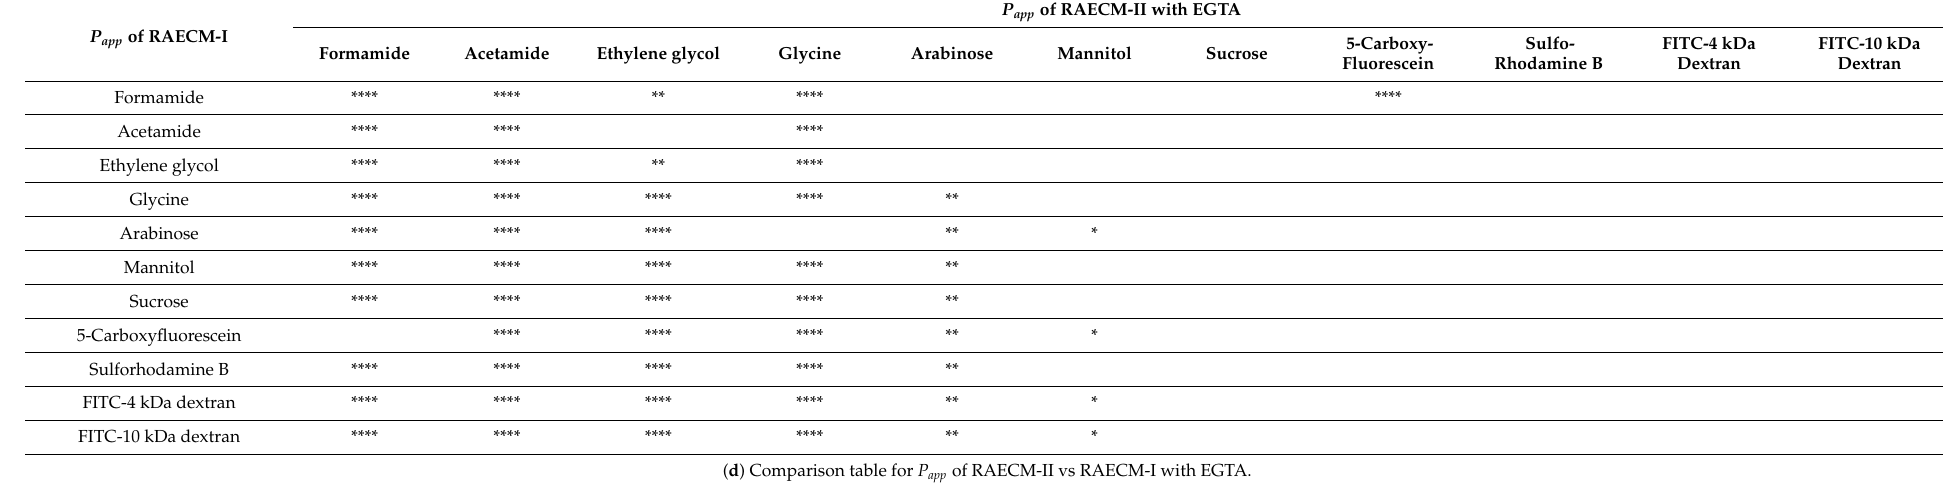
( d ) Comparison table for P app of RAECM-II vs RAECM-I with